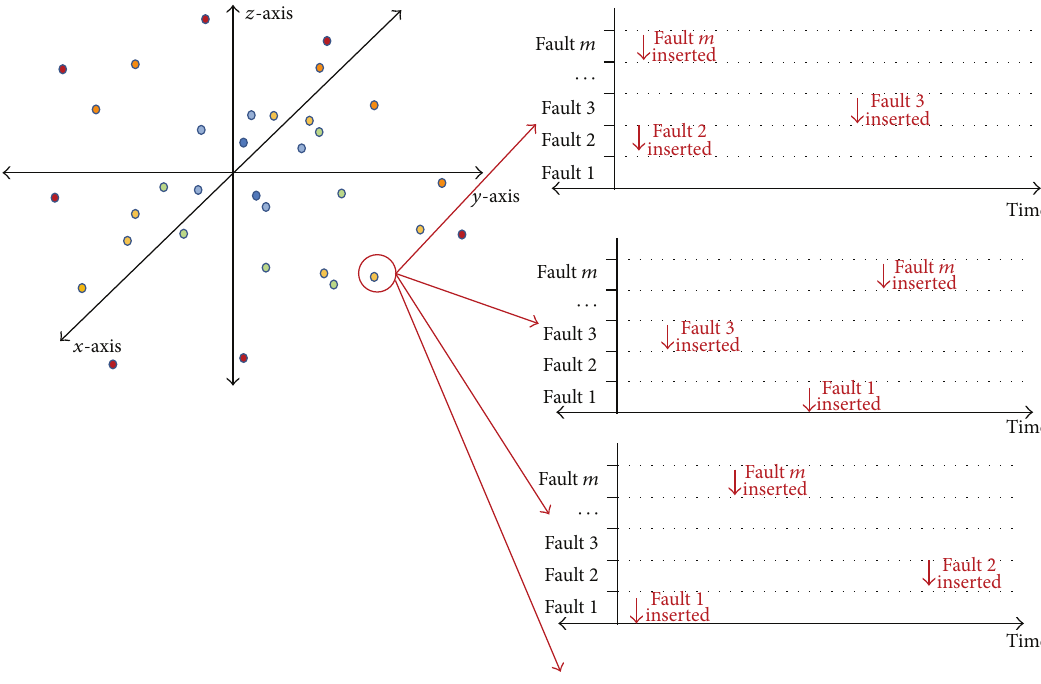
Figure 3: Example of multiple fault injection timelines occurring for a single initial